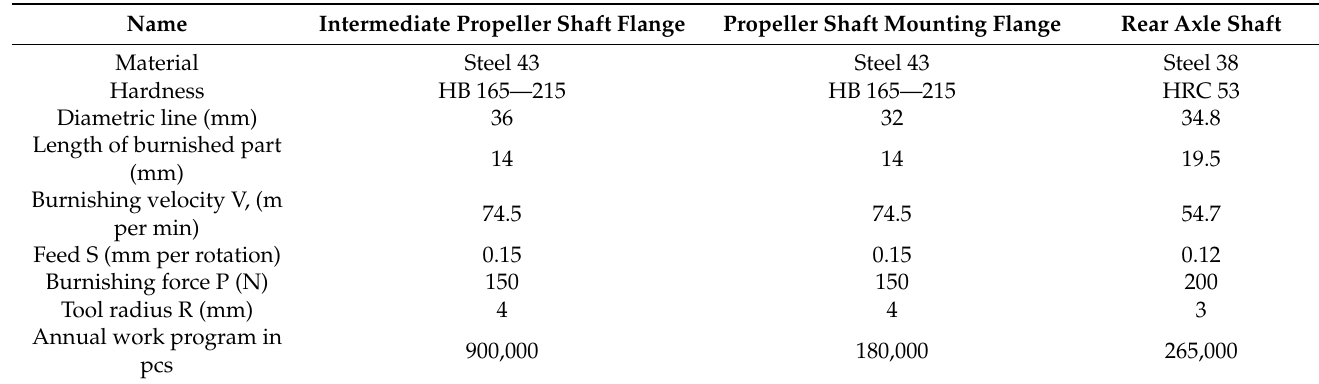
Table 1. Materials and operational parameters burnishing used in the production of Lada Niva Travel car parts at JSC “AVTOVAZ”.